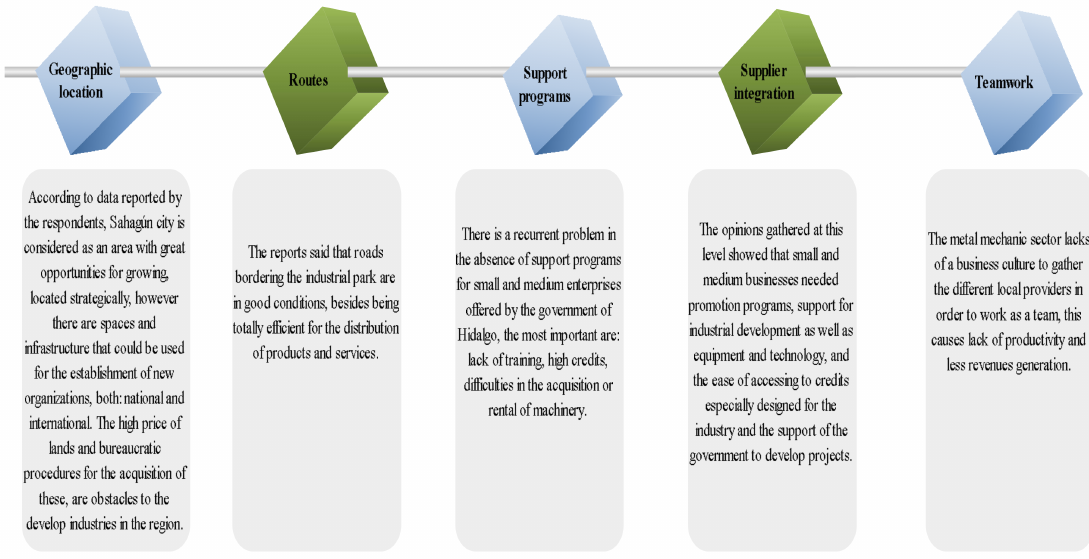
Figure 7. Production Chain. Author’s elaboration from information obtained in the focus